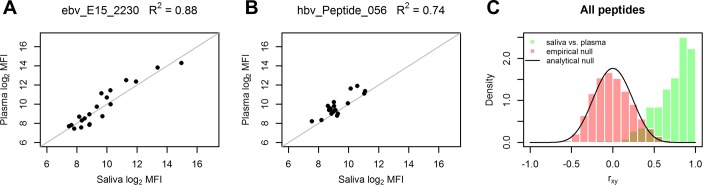
High accordance of IgG reactivities in paired plasma and saliva samples against individual peptides.(A, B) Plasma and saliva reactivities of representative EBV and HBV derived peptides. The identity line is shown in grey. (C) Distributions of Pearson correlation coefficients (rxy) between plasma and saliva intensities (green bars) for all 256 peptides (158 EBV and 98 HBV peptides) and null-distributions (red bars and black line, respectively) for comparison. Pearson’s r is shown instead of R2 in C for reasons of clarity. 47% of all peptides have rxy > 0.8, 83% have BH FDR < 0.01 (analytical Null). For comparison of resulting correlation coefficients, the null distribution (expected distribution of r in case of zero correlation or random data) is calculated in two ways. The empirical null distribution is generated by random resampling from array data. The analytical null distribution is shown for the case of independent normal variables. Note: the slight positive skew of the empirical null distribution originates from the positive skew of the data (log2 MFI of samples), which is typical for microarray data. R2 is Coefficient of determination (squared Pearson’s r).